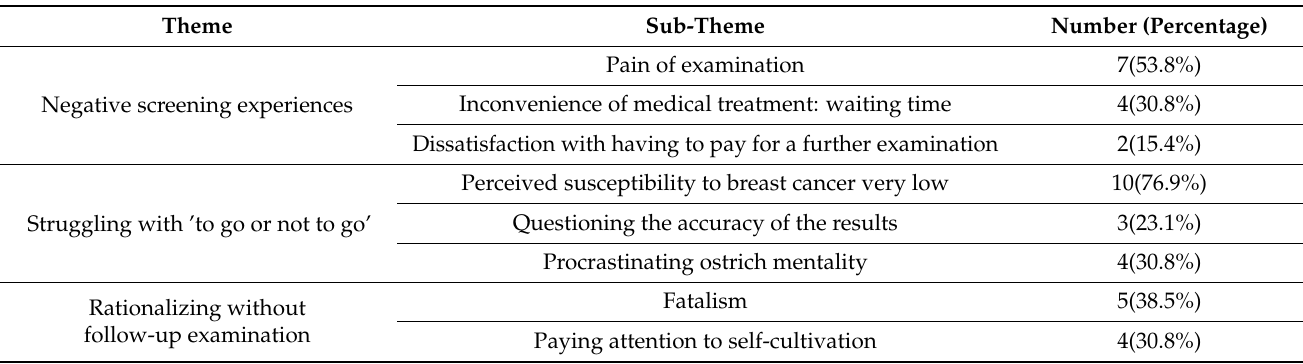
Table 2. Themes and